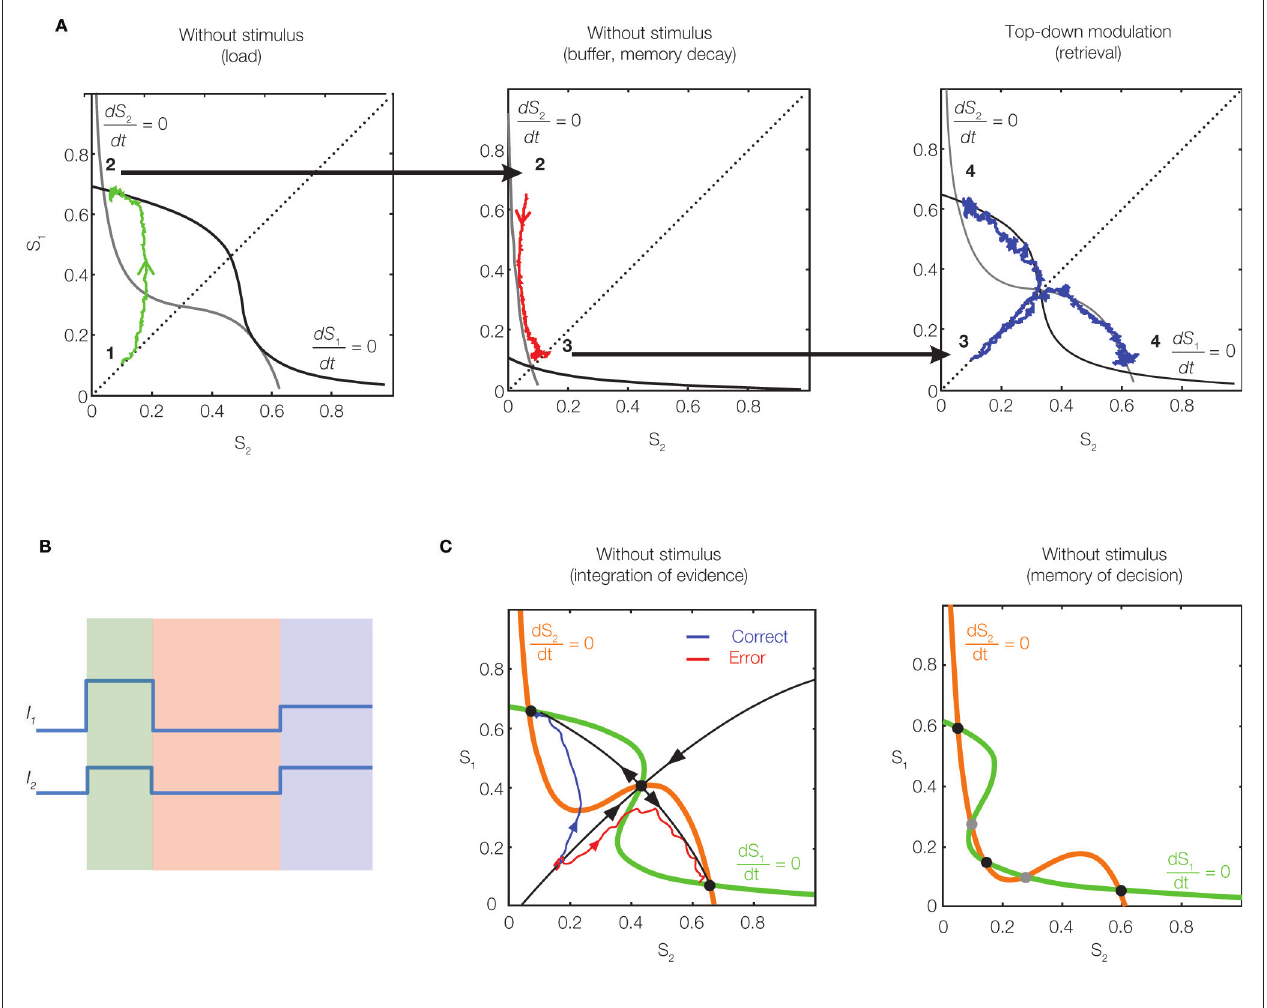
Figure 1 | Phase-space diagrams of the working memory mechanisms. The variables S and S ( S ∈ [0,1]) describe the gating of NMDA receptors, and reflect 1 2 i the spiking activity of two stimulus-selective populations. The nullclines (curves where dS / dt = 0) are drawn, and their crossing points are the fixed points of the i system. (A) Memory decay and retrieval (adapted from Zylberberg et al., 2009). First, the stimulation drives the network into a high-activity state ( left ). After the stimulation terminates, the network moves toward its single stable fixed point, representing memory decay ( middle ). Finally, the top-down signal switches the